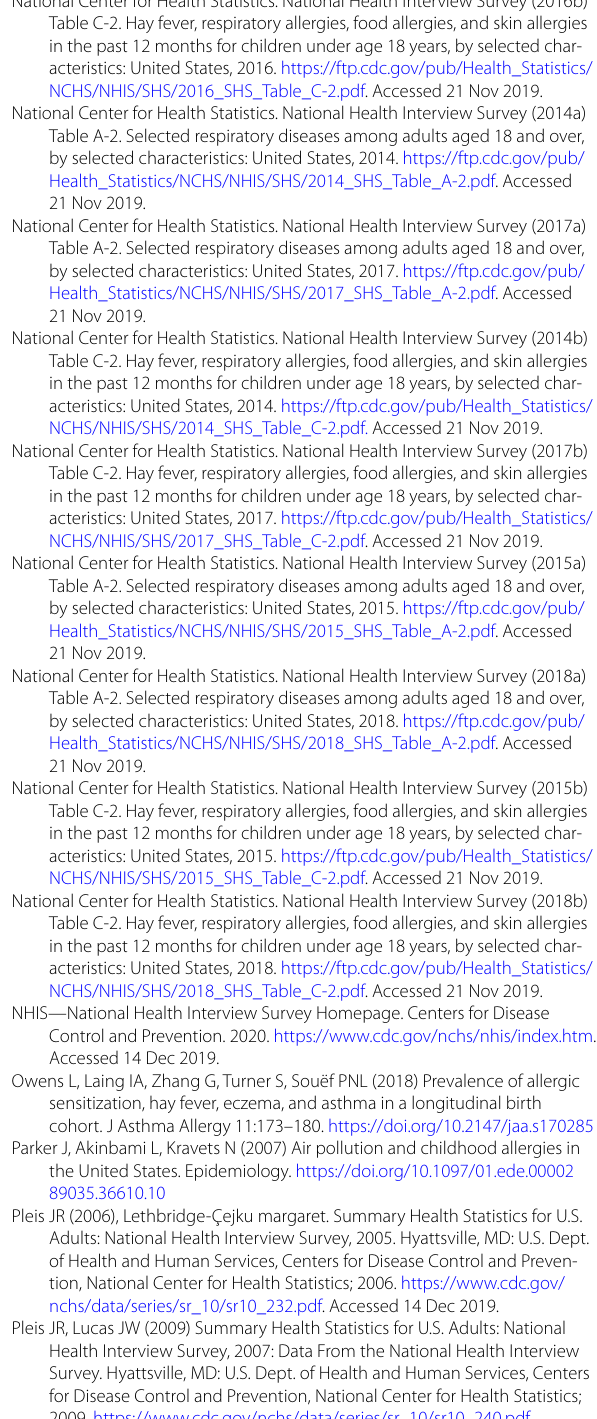
Table A-2. Selected respiratory diseases among adults aged 18 and over, by selected characteristics: United States, 2014. https:// ftp. cdc. gov/ pub/ Health_ Stati stics/ NCHS/ NHIS/ SHS/ 2014_ SHS_ Table_A- 2. pdf. Accessed 21 Nov 2019. National Center for Health Statistics. National Health Interview Survey (2017a) Table A-2. Selected respiratory diseases among adults aged 18 and over, by selected characteristics: United States, 2017. https:// ftp. cdc. gov/ pub/ Health_ Stati stics/ NCHS/ NHIS/ SHS/ 2017_ SHS_ Table_A- 2. pdf. Accessed